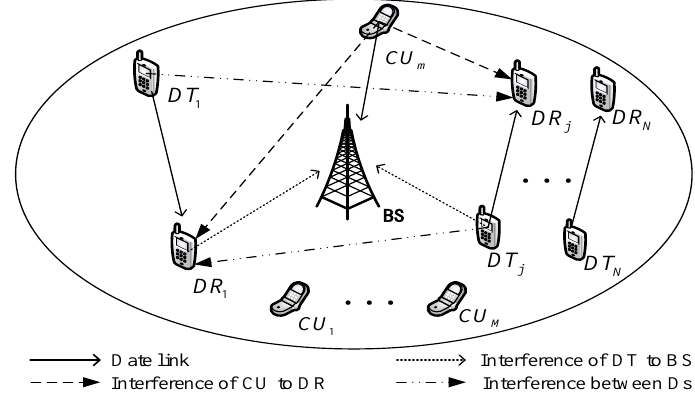
Figure 1. System model of device-to-device (D2D) communication underlaying cellular network.